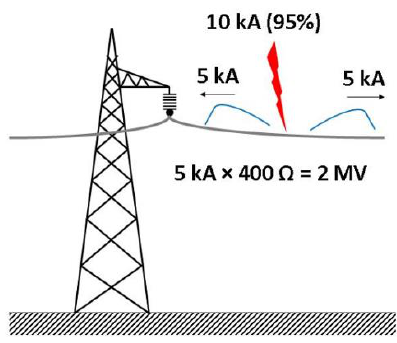
Figure 5. The illustration of a shielding failure event.